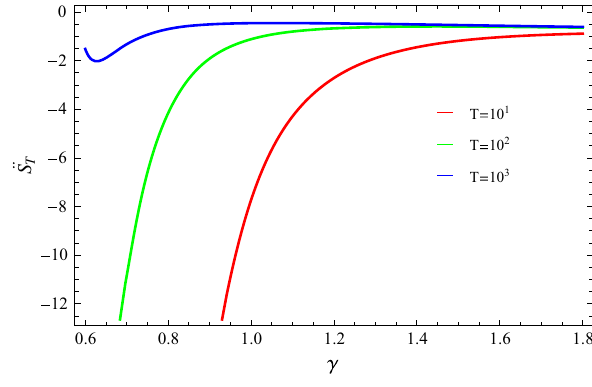
Fig. 9 Plot of ¨ S T versus γ